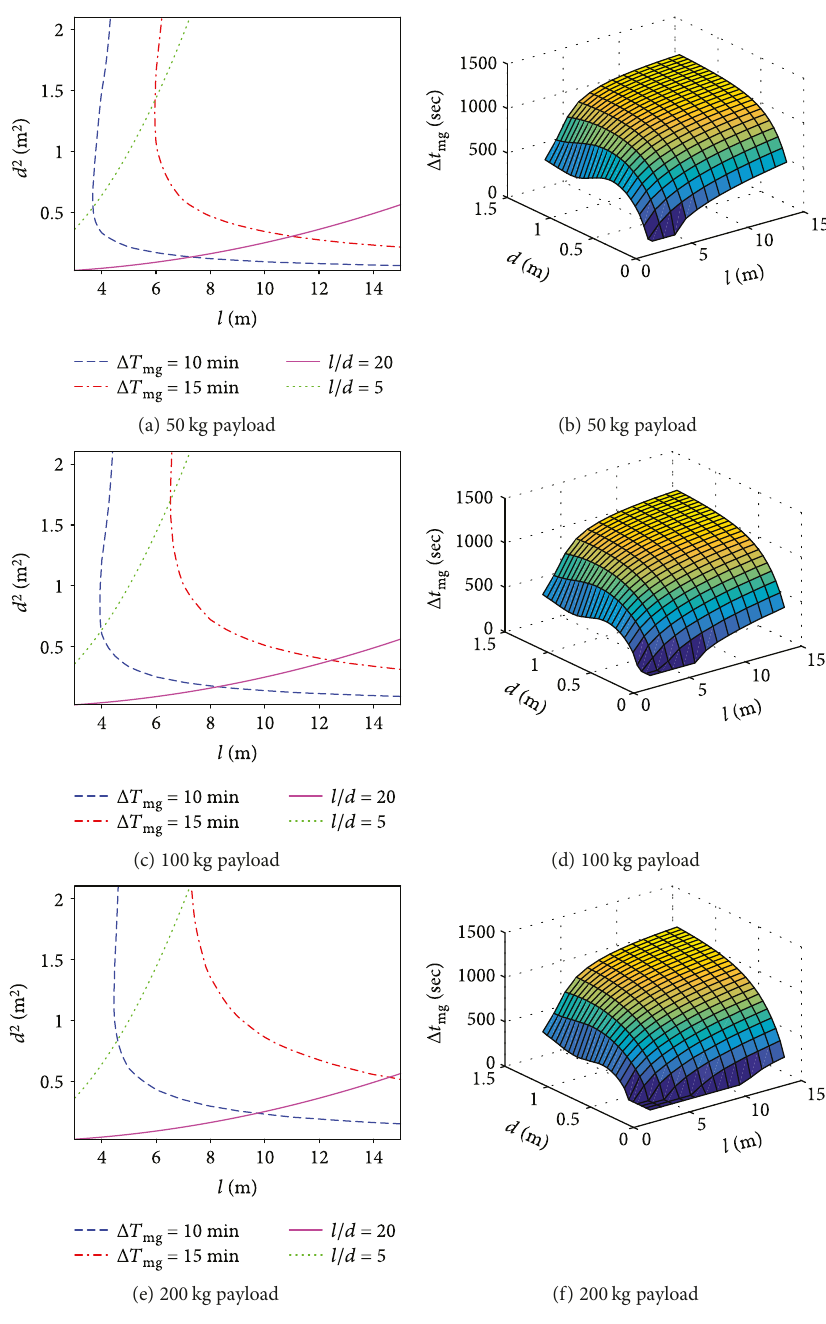
Figure 11: Optimal results for the sun-pointing guidance. Table 6: Optimal con fi gurations for each payload mass, Δ T = mg 15